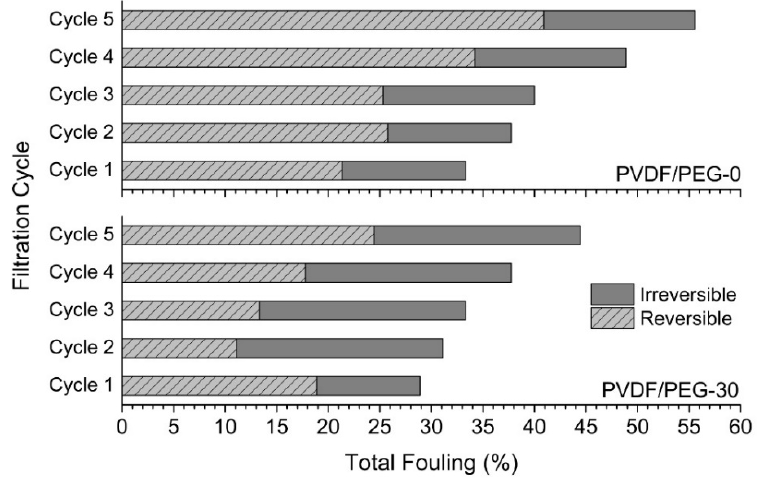
Figure 11. Fouling resistance analysis of modified membranes developed using NIPS (PVDF / PEG-0, up) and VIPS (PVDF / PEG-30, bottom) techniques.